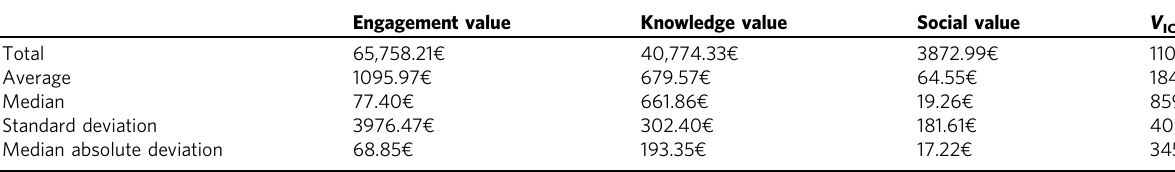
Table 3 Model results for sample N = 60.